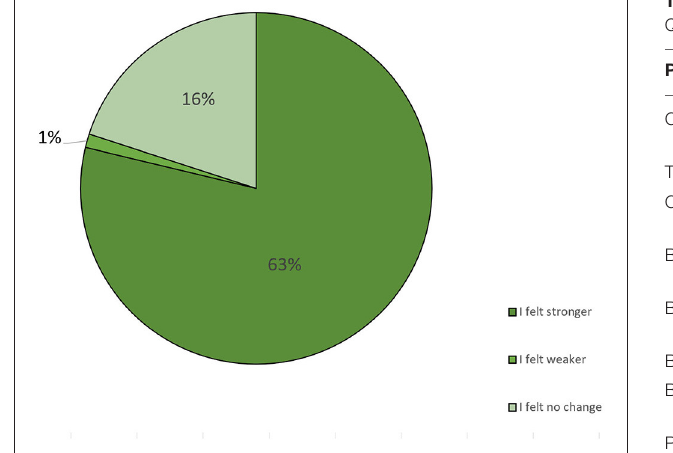
FIGURE 5 | Changes noticed in the quality of life after implementing the diet ( n = 94).